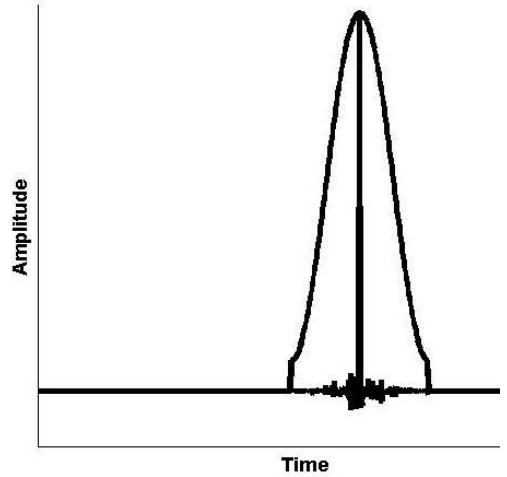
Fig.1. Location of the monitoring sites PYR (A), ATH (B), and HIO (C) (Thanassoulas, C., 2007). Fig.2. Flowchart of the proposed feature extraction technique.